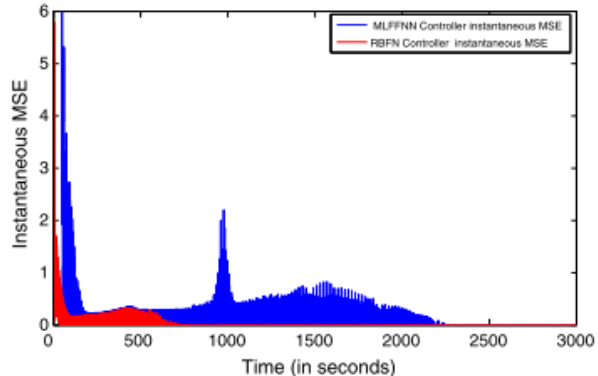
Figure 4. RBFN-based control configuration for trajectory control of two-link robotic manipulator [59] (Copyright 2016, Springer Nature).